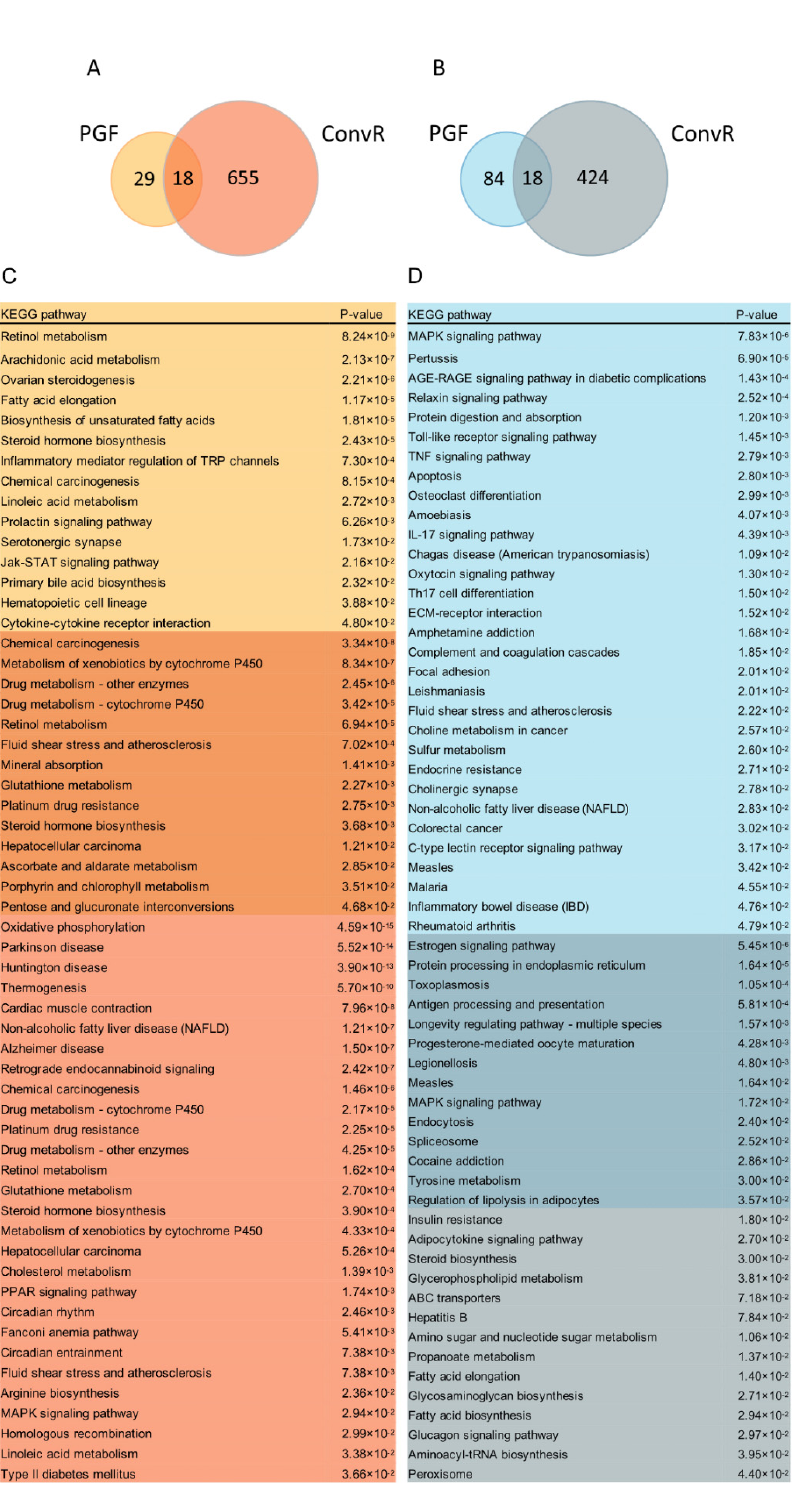
versus ConvR Chow, log2). ( B ) Interaction network for 244 differentially expressed hepatic genes regulated by HFD fed. Node color indicates relative expression in ConvR HFD mouse livers. Node